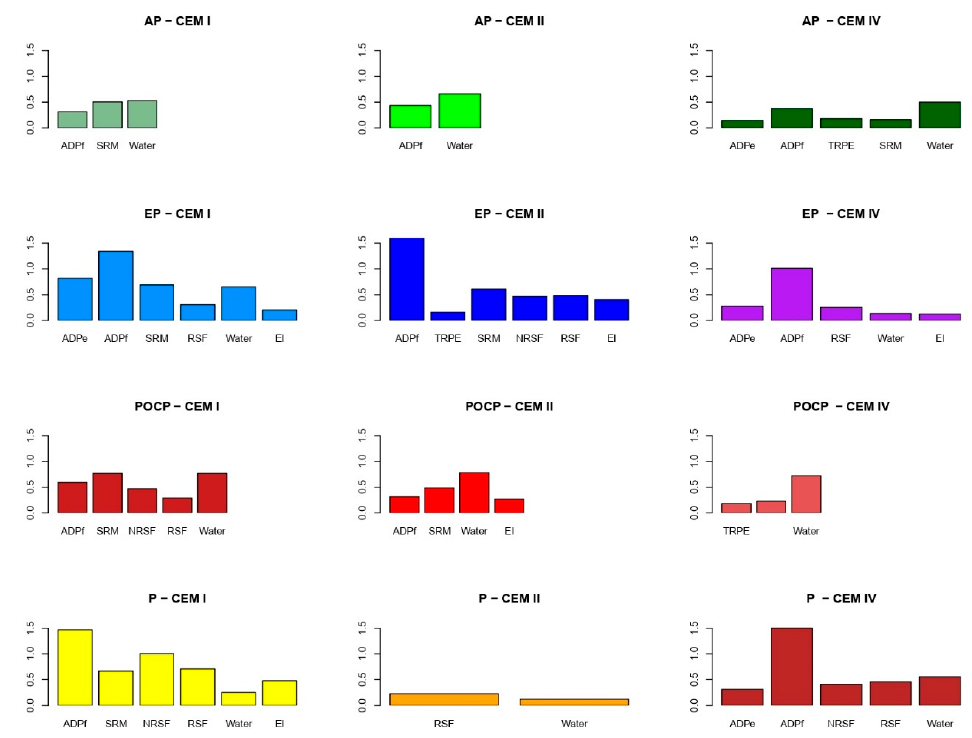
Figure 8. Size of the coefficients (AIC selected components) for each class and for all the remaining Emission ICs. (absolute values).